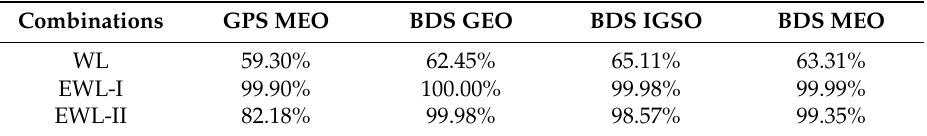
Table 8. Fixing rate of GPS/BDS AR. The fixing rate of the WL combination is computed based on the HMW combination. The fixing rates of theb EWL-I and EWL-II combinations are computed based on Equations (3) and (5), respectively.